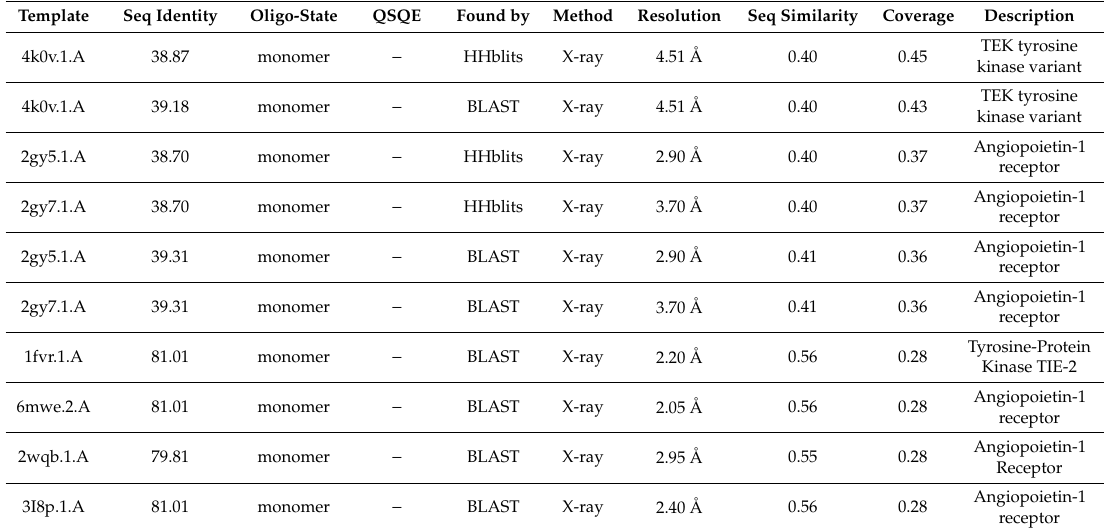
Figure 3. Molecular interactions of ( a ) Arg436 and ( b ) Cys436 (in yellow) of the modeled TIE1 protein with adjacent residues. Table 6. Details of molecular interactions of Arg436 and Cys436 of the modeled TIE1 protein with adjacent residues.